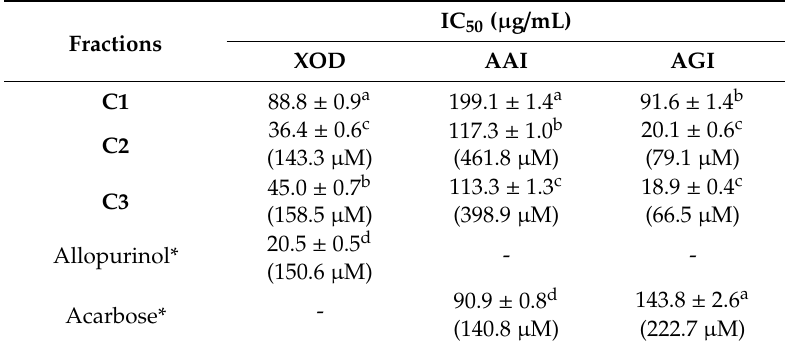
Table 5. Xanthine oxidase, α -amylase and α -glucosidase inhibitory activities of isolated fractions from Rumex crispus root in term of IC 50